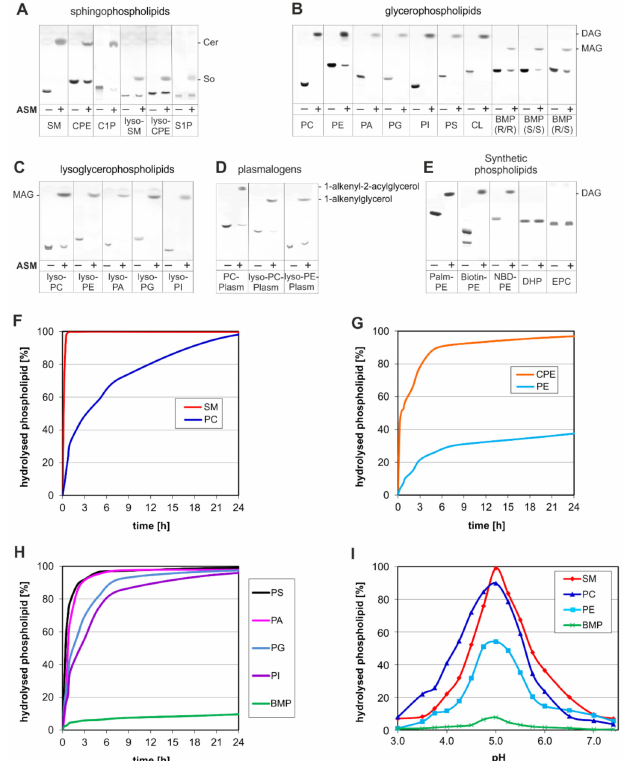
Figure 2. Degradation of phospholipids by recombinant ASM. The ability of ASM to hydrolyze ( A ) sphingophospholipids, ( B ) glycerophospholipids, ( C ) lysoglycerophopholipids, ( D ) plasmalogens (Plasm) and in ( E ) synthetic phospholipids ( N -palmitoyl-dipalmitoyl phosphatidylethanolamine (Palm-PE), N -biotin-phosphatidylethanolamine, N -NBD-phosphatidylethanolamine and dicetylphos- phate (DHP)) was tested in a detergent-based assay. 15 µ g lipid were incubated in 20 mM sodium citrate buffer containing 0.05% Triton X 100 (pH 5) in a final volume of 100 µ L with 10 µ g recombinant ASM [62] for 24 h at 37 ◦ C. The reaction was stopped by the addition of 350 µ L chloroform/methanol 1:2 ( v/v ), to obtain a homogeneous phase. For lipid separation by thin-layer chromatography, the chromatograms were developed with chloroform/methanol/water (60:25:4, v/v/v ) up to 7.5 cm and twice with n-hexane/diethylether/glacial acetic acid (70:30:1, v/v/v ) up to the end (10 cm). To identify the hydrolysis products, standard lipids (ceramide, diacylglycerol, monoacylglycerol, palmitic acid, and sphingosine) were applied. The developed thin-layer chromatography plates were sprayed with an aqueous solution, containing 8% ( w/v ) H 3 PO 4 (85%) and 10% ( w/v ) CuSO 4 , and charred at 180 ◦ C for 10 min. In ( F – H ) time dependent and ( I ) pH dependent studies, the lipids were incubated under the same conditions as in ( A – E ), but by varying the time (0–24 h) or the pH values of the assay (3.5–7.4) as indicated. For quantitative analytical thin-layer chro- matography determination, increasing amounts of standard lipids were applied and the plates were quantified by scanning densitometry at 595 nm. Biotin-PE: N -[6-(biotinoyl)amino]hexanoyl-1,2- dihexadecanoyl- sn -glycerol-3-phosphoethanolamine, BMP: bis(monoacylglycero)phosphate, C1P: ceramide-1-phosphate, Cer: ceramide, CL: cardiolipin, CPE: ceramide phosphoethanolamine, DAG: diacylglycerol, DHP: dihexadecyl phosphate also called dicetylphosphate, EPC: 1,2-dioleoyl- sn - glycero-3-ethylphosphocholine, lyso-CPE: sphingosyl phosphoethanolamine, lyso-PC-Plasm: 1- O -1 (cid:48) - ( Z )-octadecenyl-2-hydroxy- sn -glycero-3-phosphocholine, lyso-PE-Plasm: 1- O -1 (cid:48) -( Z )-octadecenyl-2- hydroxy- sn -glycero-3-phosphoethanolamine, MAG: monoacylglycerol, NBD-PE: N -(7-nitrobenz- 2-oxa-1,3-diazol-4-yl)-1,2-dihexadecanoyl- sn -glycero-3-phosphoethanolamine, PA: phosphatidic acid, Palm-PE: N -palmitoyl-phosphatidylethanolamine, PC: phosphatidylcholine, PC-Plasm: 1- (1 Z -octadecenyl)-2-docosahexaenoyl- sn -glycero-3-phosphocholine, PE: phosphatidylethanolamine, PG: phosphatidylglycerol, PI: phosphatidylinositol, PS: phosphatidylserine, S1P: sphingosine-1- phosphate, SM: sphingomyelin, So: